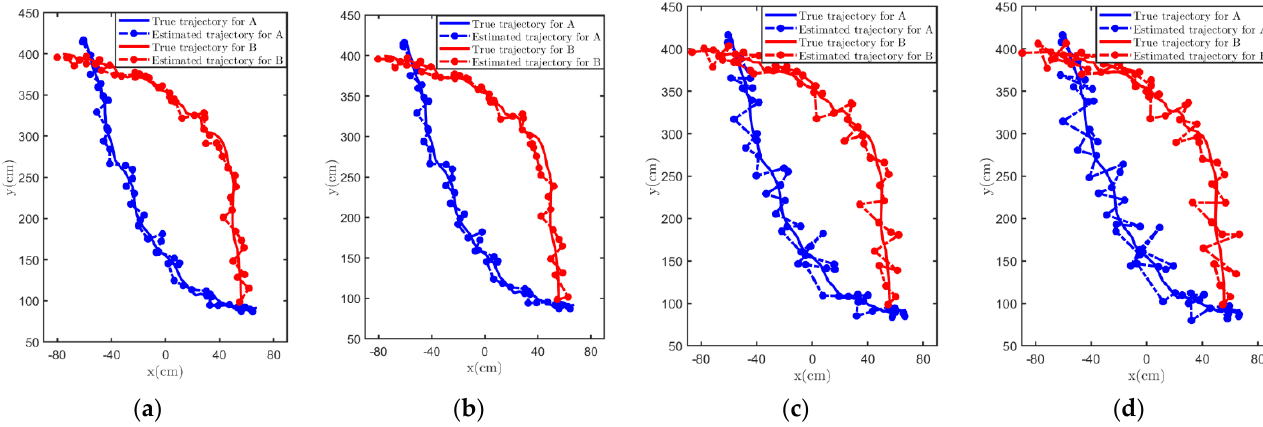
Figure 8. The fitting degree between the estimated trajectory and the true trajectory after processing by various Kalman filtering methods in an indoor scene. ( a ) OBKF. ( b ) KFPNS. ( c ) IBRKF. ( d ) CKF.